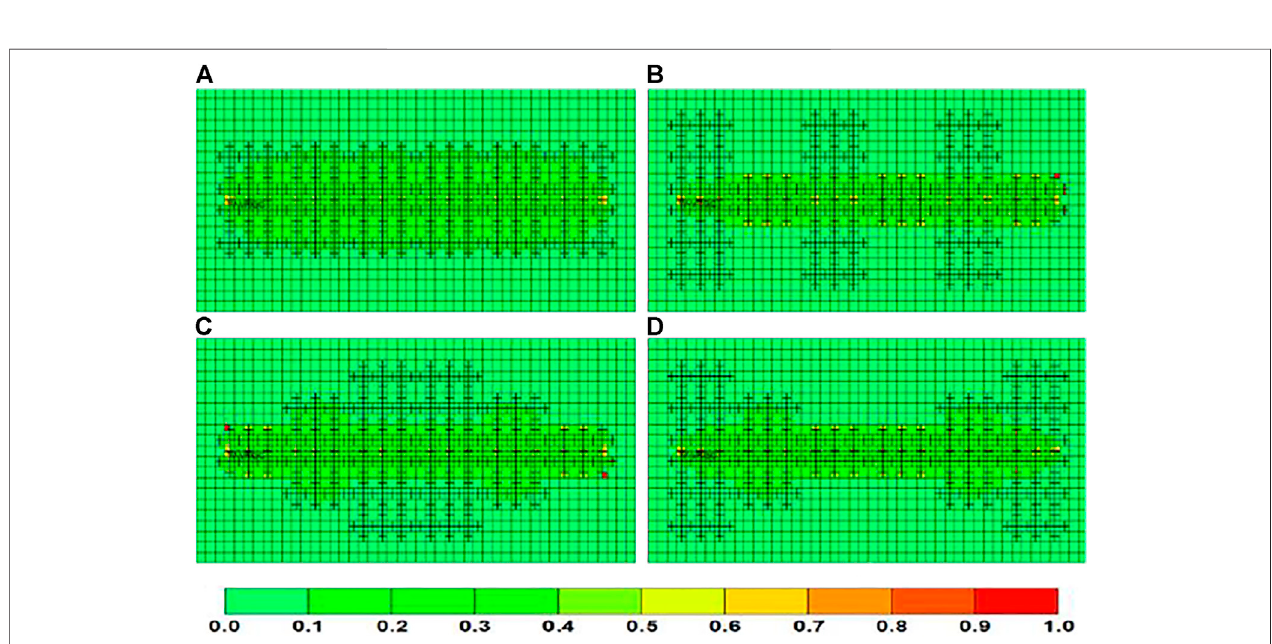
FIGURE 15 | Oil saturation distribution map of horizontal wells with different fracture laying patterns.